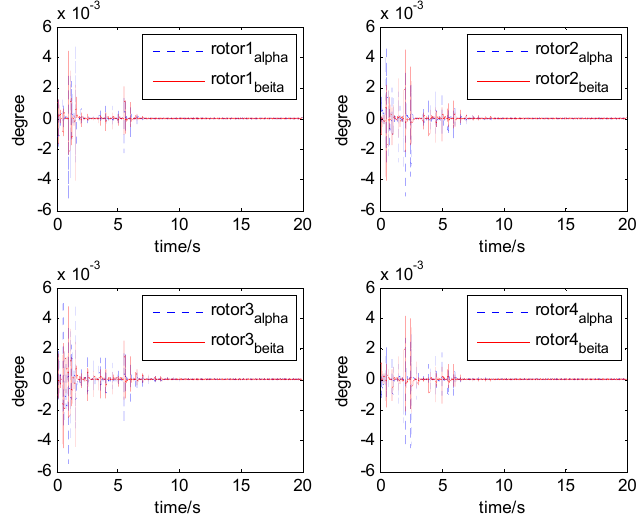
Figure 21. The magnetically suspended rotor tilt curves relative to rotor center after